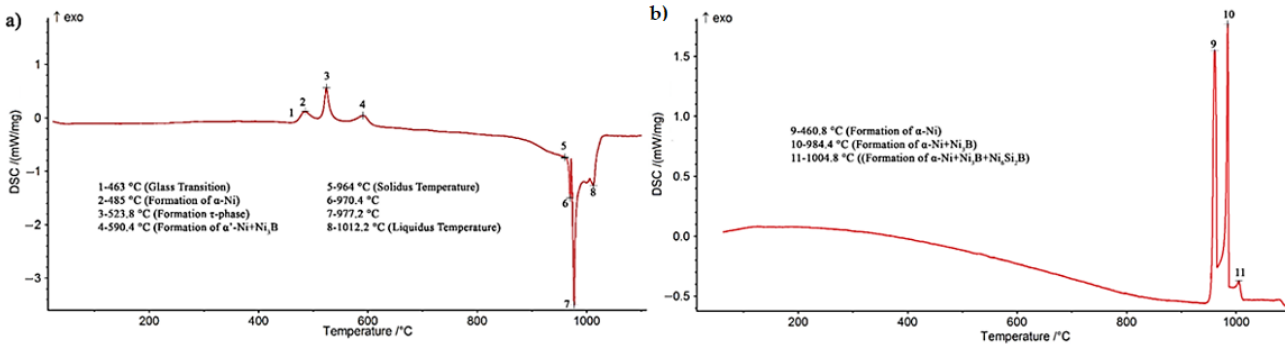
Figure 2. DSC trace during ( a ) heating and ( b ) cooling from 1100 ◦ C for BNi-3 foil alone, showing transformation phenomena at each stage.